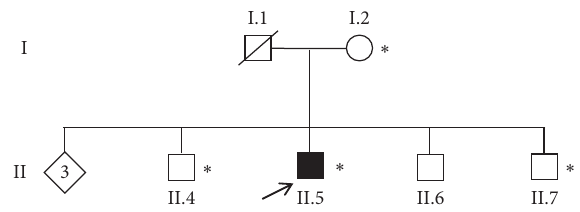
Figure 1: Pedigree of the family studied. ↗ : index patient. ∗ : ge- netic testing